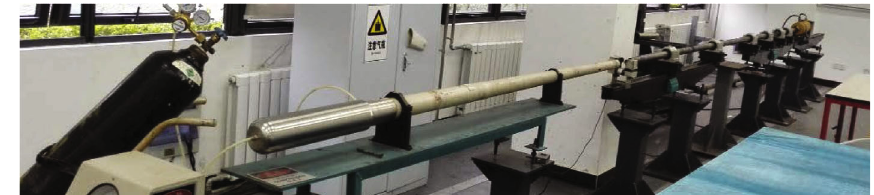
Figure 2: Dynamic impact test equipment (SHPB).